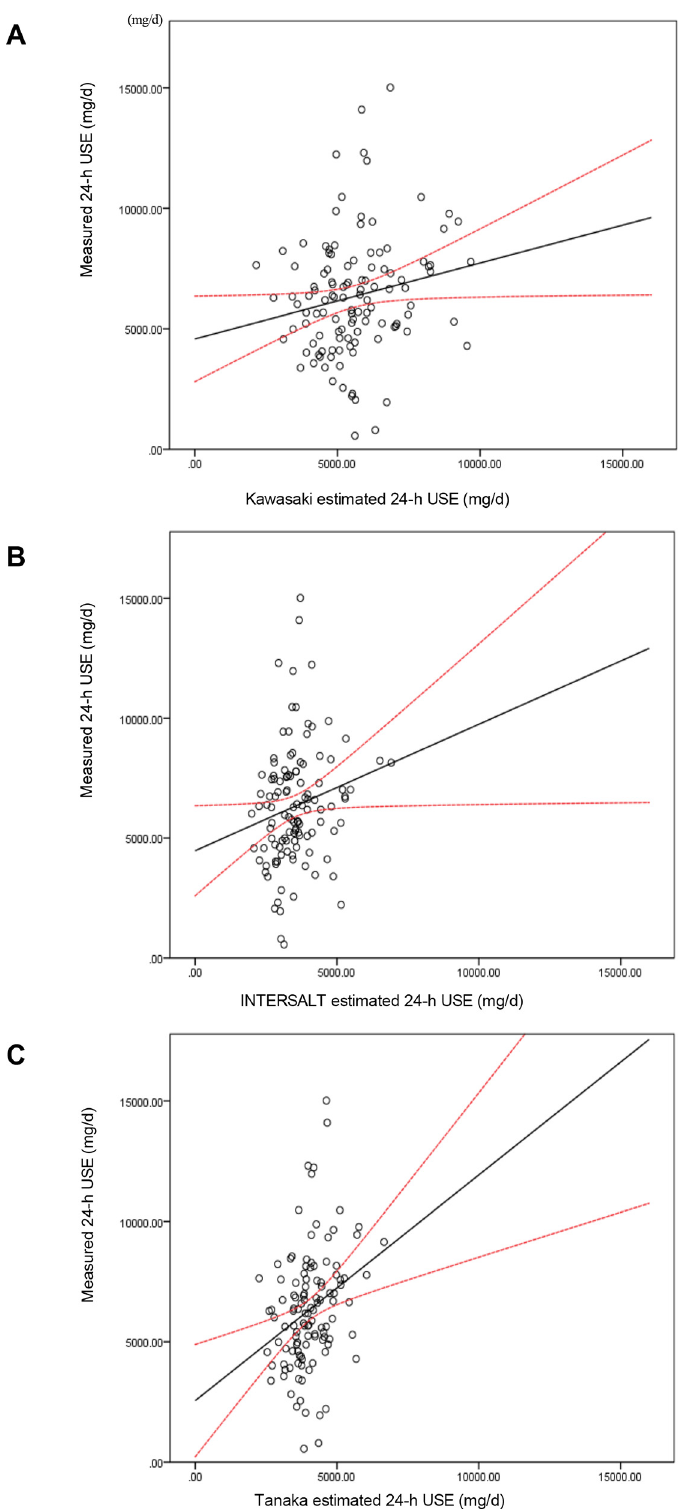
Fig 1. Scatter plots measured 24-h urine sodium excretion (USE) vs. Kawasaki (A), INTERSALT (B), and Tanaka (C) method estimated 24-h USE (mg/d). The hollow circles were scatter points of measured and estimated values. The real line was the linear regression line of the scatters in the plots. The dash lines were the 95% CI lines of predicted mean. doi:10.1371/journal.pone.0149655.g001 PLOS ONE | DOI:10.1371/journal.pone.0149655 February 19,